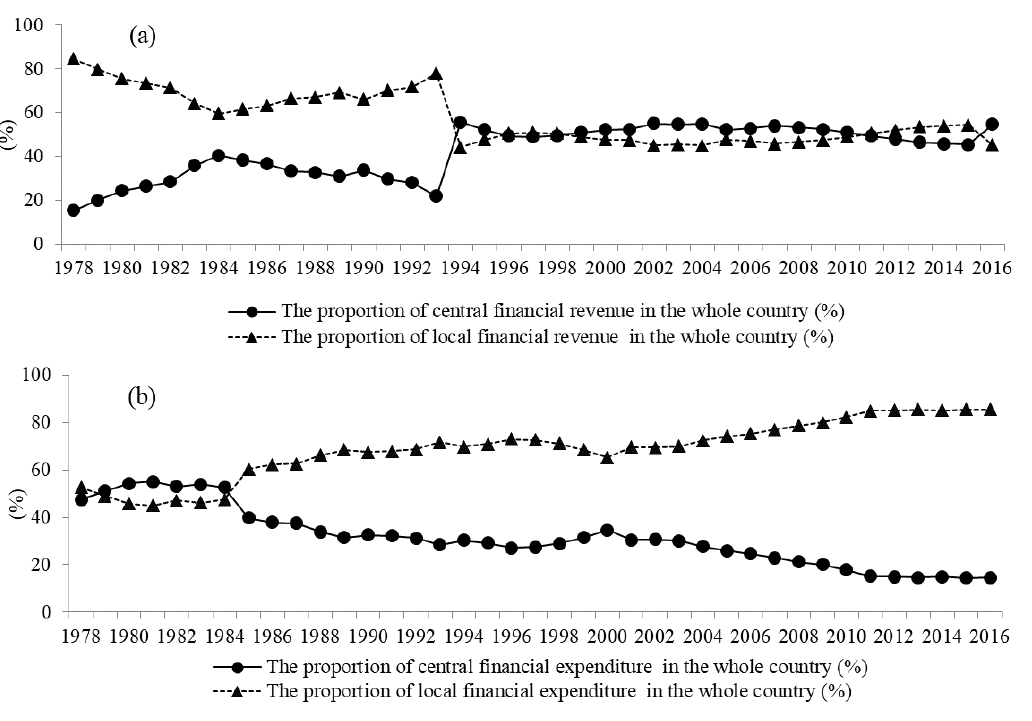
Figure 1. The proportions of financial revenue ( a ) and expenditure ( b ) between central and local governments.